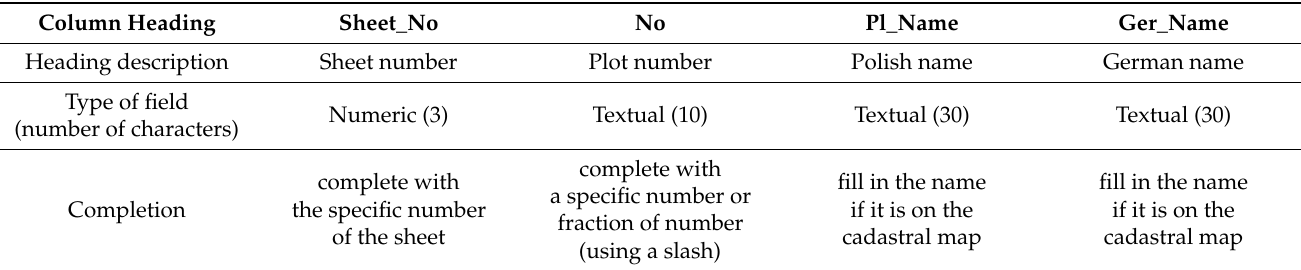
Table 1. An example of the structure and information scope for the “plots” layer.